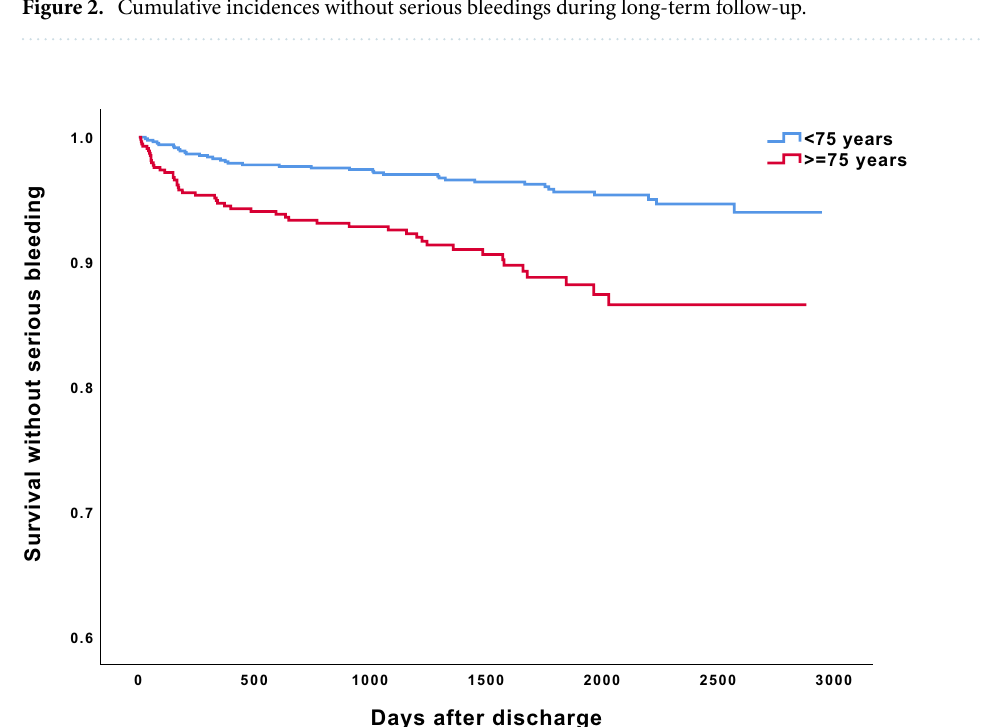
Figure 3. Cumulative incidences without serious bleedings during long-term follow-up, stratified by